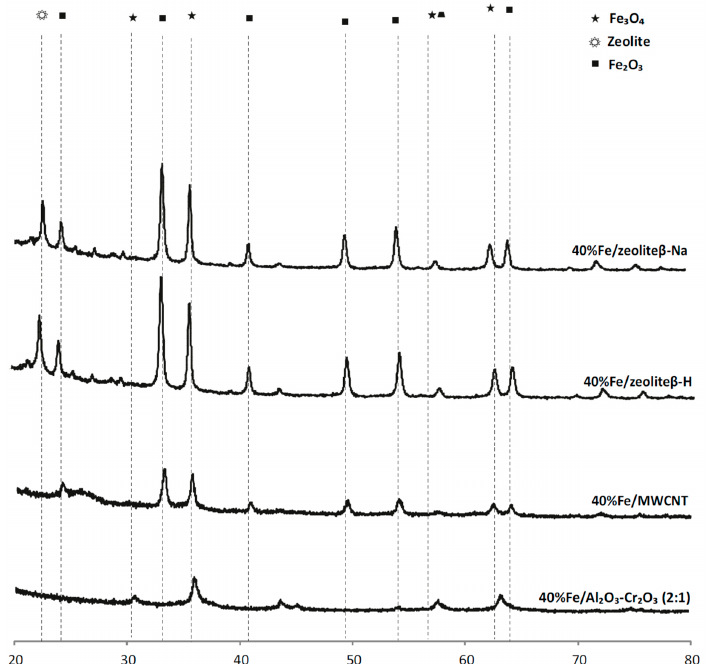
Figure 6. The X-ray diffraction patterns recorded for calcined iron catalysts supported on MWCNTs and binary oxide support.